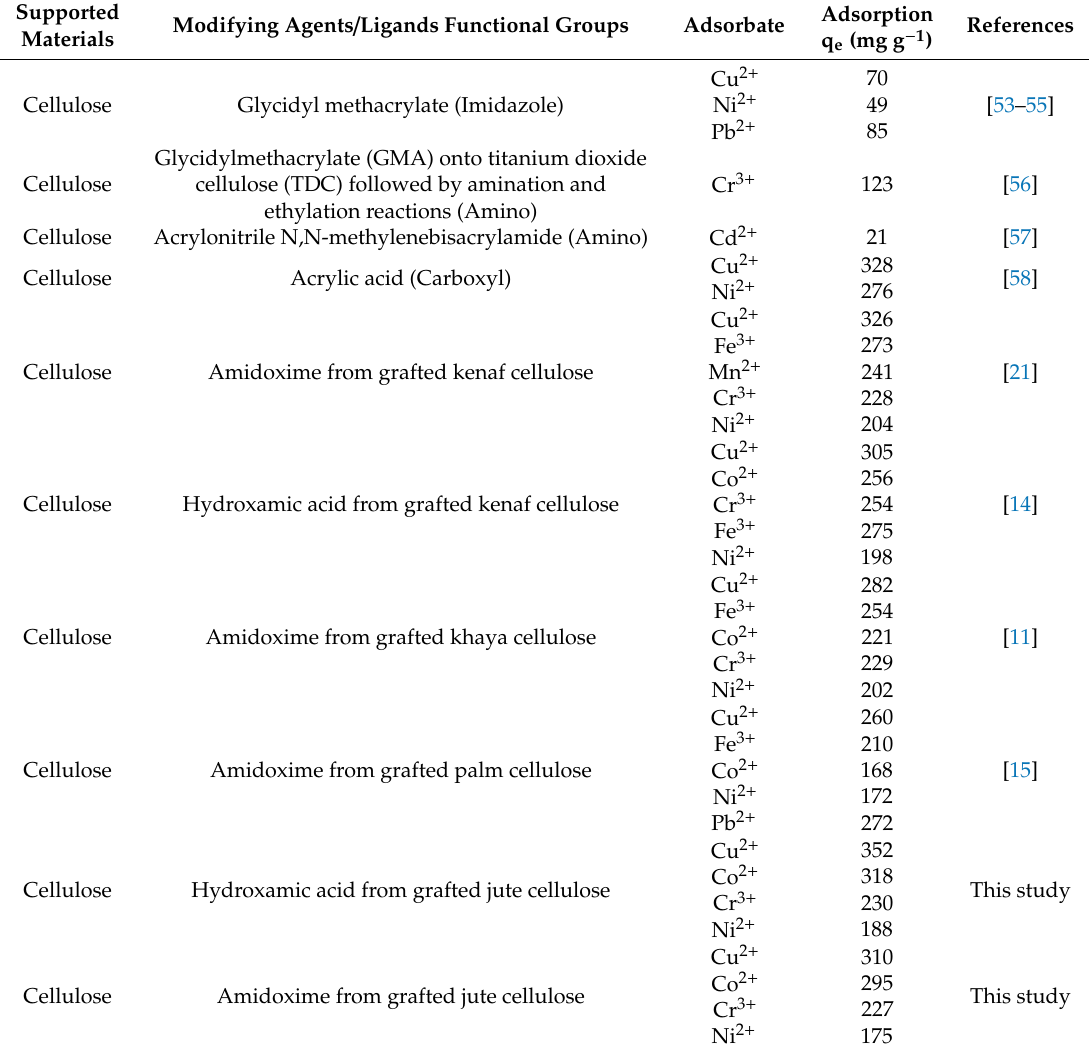
Table 7. Chemically modified grafted cellulose with various modifying agents / ligands functional groups, adsorbates and their adsorption capacities for di ff erent